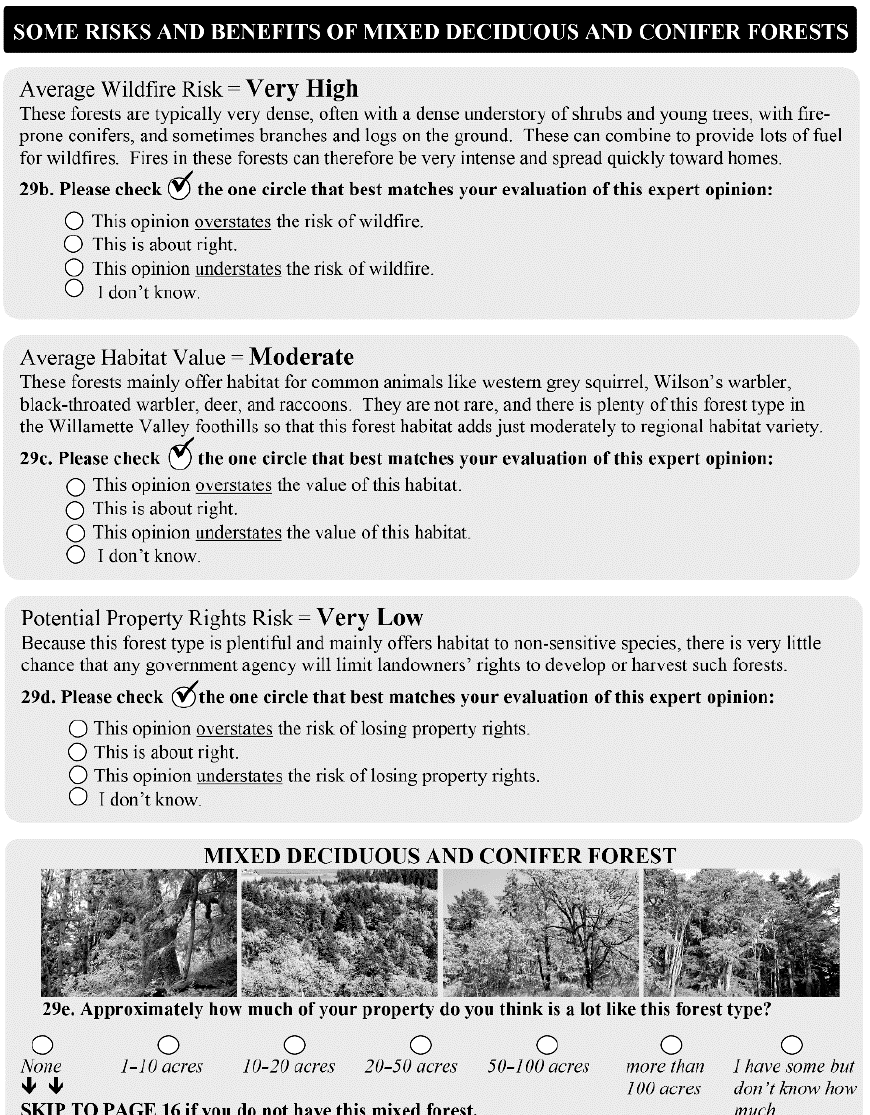
Figure 3. Example survey page where respondents rate key attributes for a forest